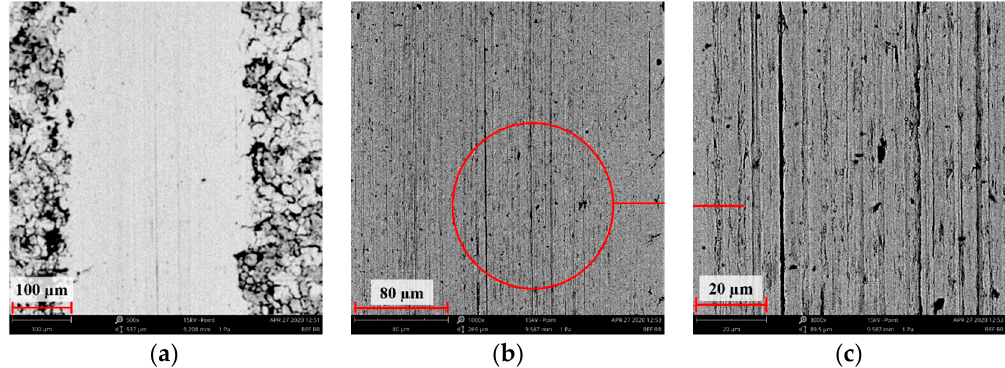
Figure 23. SEM image of the steel 316L wear track after RS-lubricated friction: ( a ) ×500, ( b ) ×1000, ( c ) ×3000.